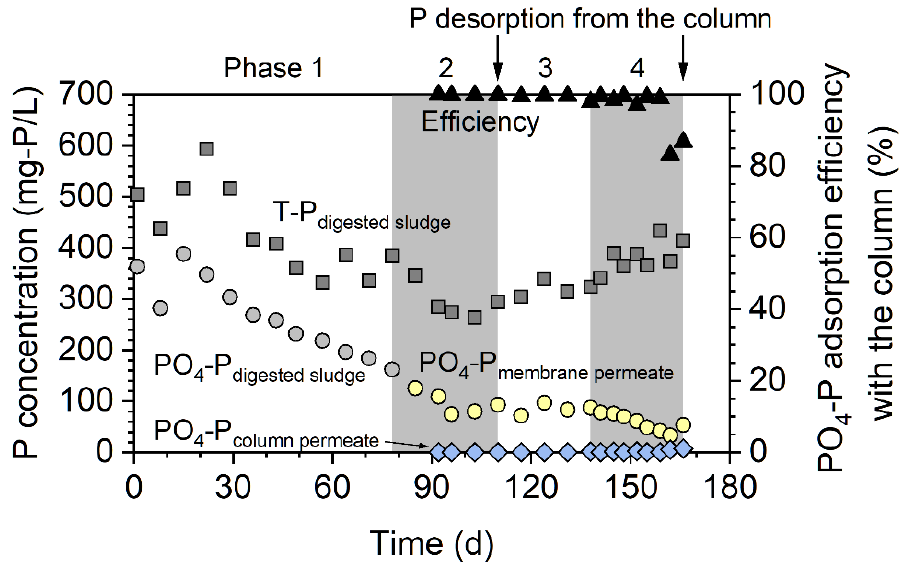
Figure 2. Total phosphorus and orthophosphate concentrations as well as the adsorption efficiency of orthophosphate to the column.